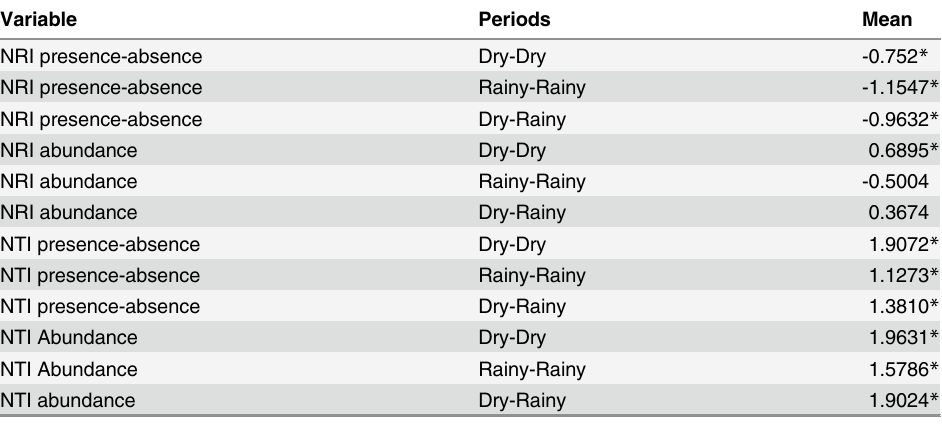
Table 2. Values of standardized phylobetadiversity (betaNRI and betaNTI) in Dry-Dry, Rainy-Rainy, and Dry-Rainy periods.